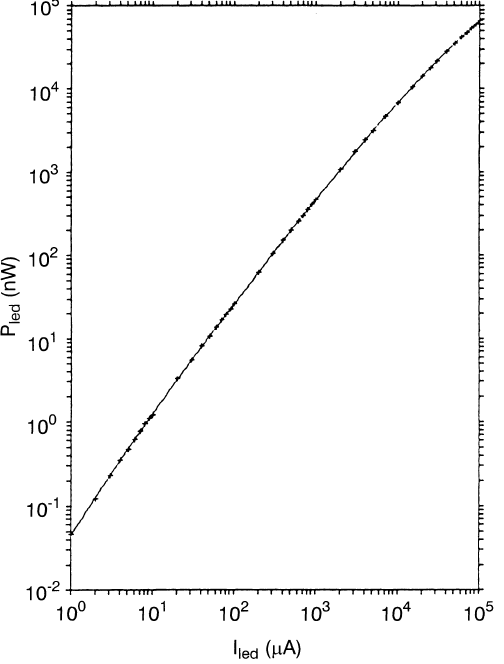
Fig. 10. Results of the LED calibration. The curve corresponds to the best fit of the data